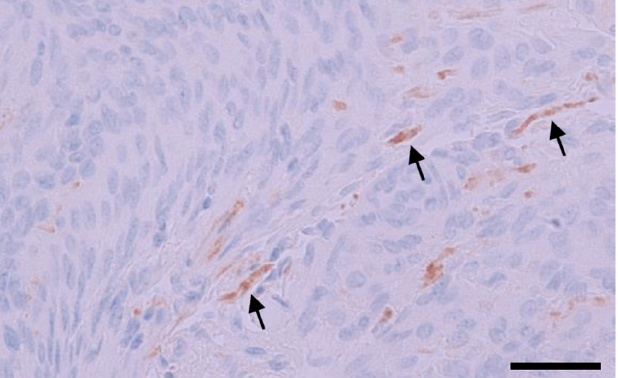
Figure 8. A meningioma sample (MGM-4) was stained with H09 (1.63 µg/mL), with nonspecific stain at some fibrotic components (arrows; score 1). UltraView, visualized with DAB, and counterstained with hematoxylin. Scale bar = 50 µm.